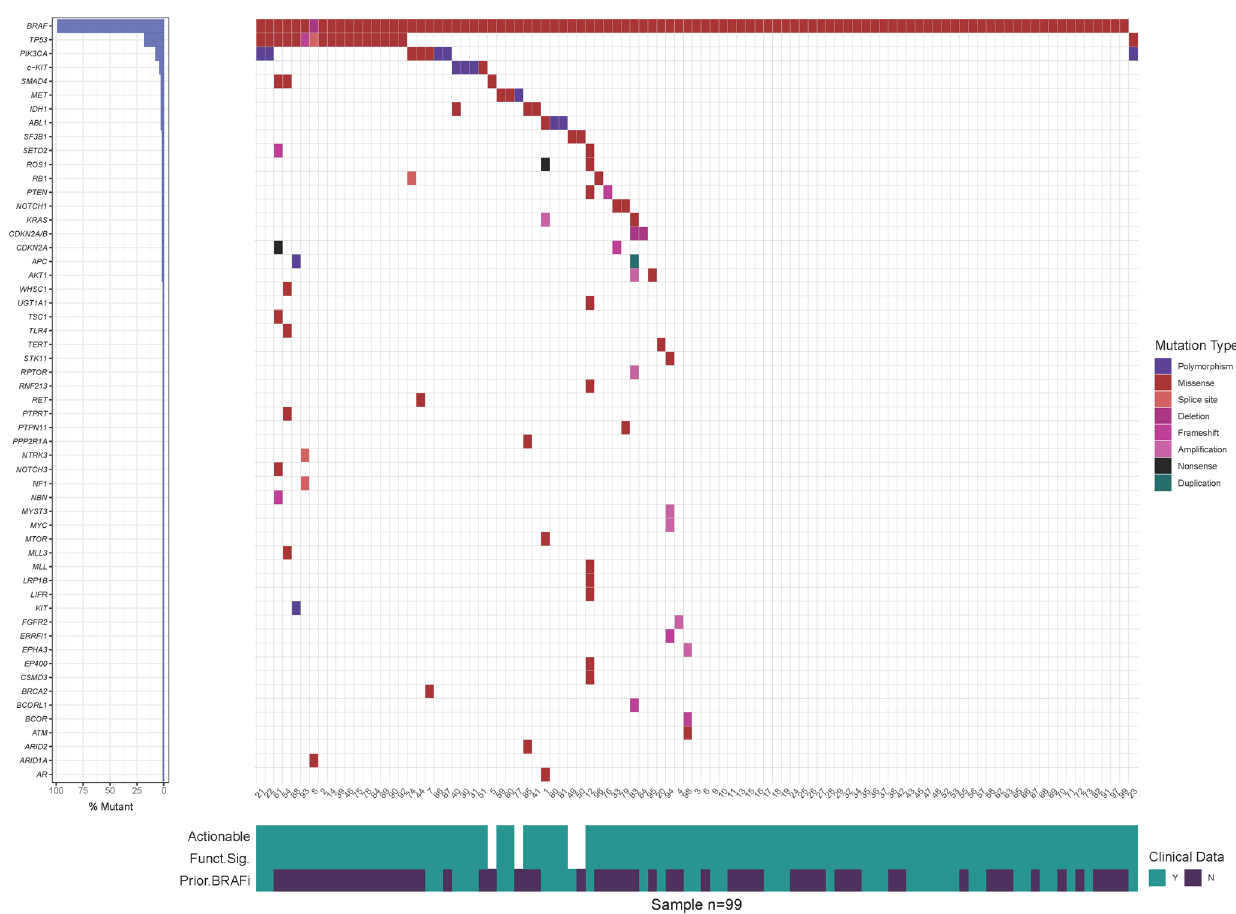
Fig. 5 Survival outcomes based on crossover status. The median progression-free survival duration of crossover patients (3.67 months) was signi fi cantly shorter than that of non-crossover patients (7 months) ( P =